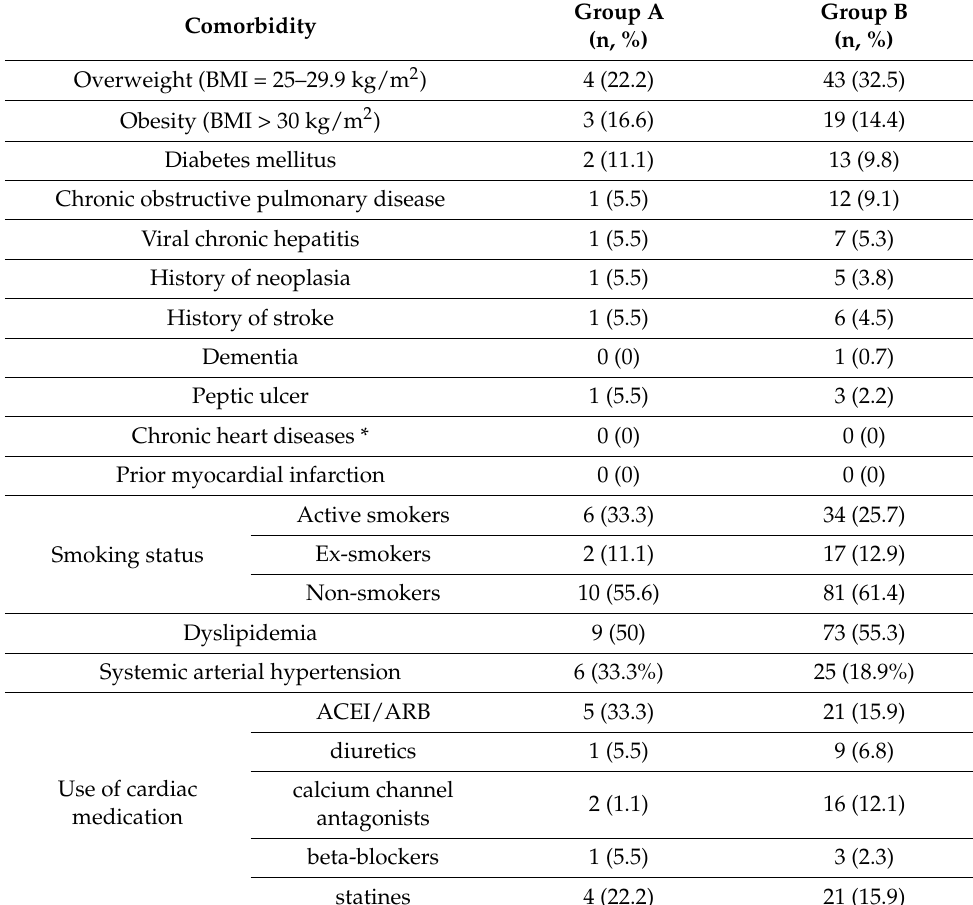
calcium channel antagonists beta-blockers statines 4 (22.2) 21